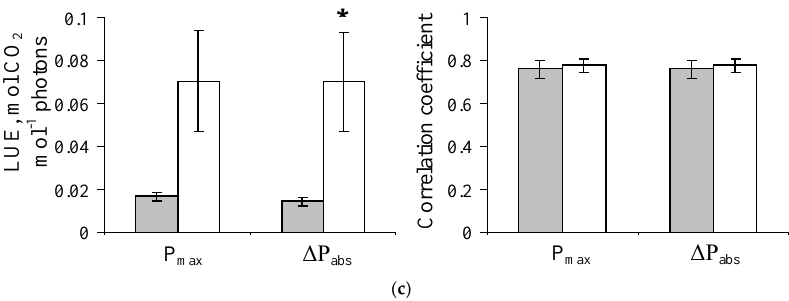
Figure 4. The influence of the distribution of ΔF/F m ’ ( a ); NPQ ( b ) and LUE ( c ) on investigated plants for the connection between these photosynthetic parameters with PRI at measurements of the photochemical reflectance index in leaves. Average values of P min (P max ) and ΔP abs are shown on left panels, average correlation coefficients are shown on right panels. The label “low” indicates groups with low P min (P max ) and ΔP abs ; the label “high” indicates groups with high P min (P max ) and ΔP abs . “Low” groups had n = 43 (ΔF/F m ’), n = 19 (NPQ), and n = 8 (LUE); “high” groups had n = 43 (ΔF/F m ’), n = 19 (NPQ), and n = 7 (LUE). * the group significantly differed from another one ( p < 0.05, Student’s test ).